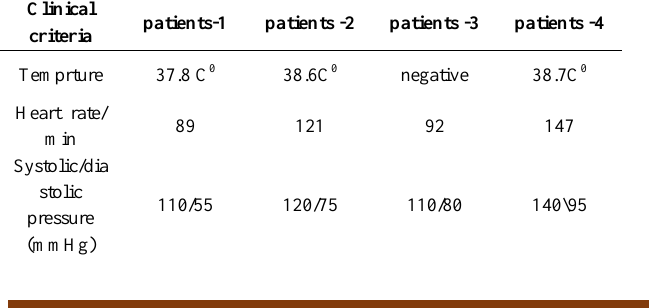
The clinical and laboratory results of the patients.